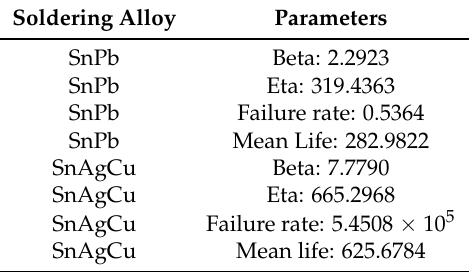
Table 5. Reliability